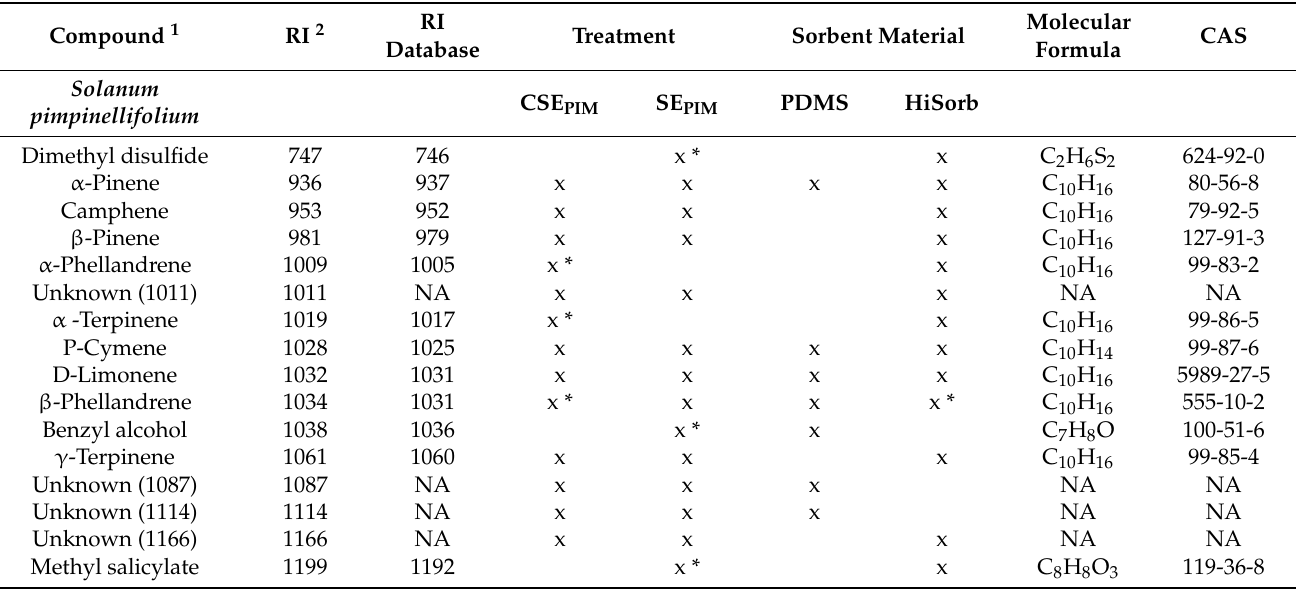
Table 2. List of root volatile compounds found in S. pimpinellifolium in stressed (SE PIM ) and non- stressed (CSE PIM ) plants detected with PDMS and HiSorb. Compounds marked with an asterisk (*) in the Treatment column were uniquely detected in the stressed (SE) or non-stressed (CSE) treatments with the indicated trapping